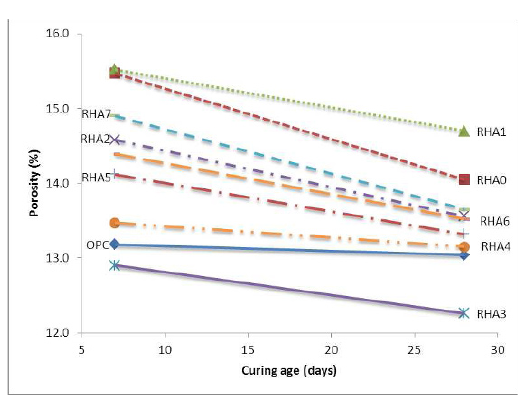
Figure 10. Relationship between coefficient permeability versus porosity.